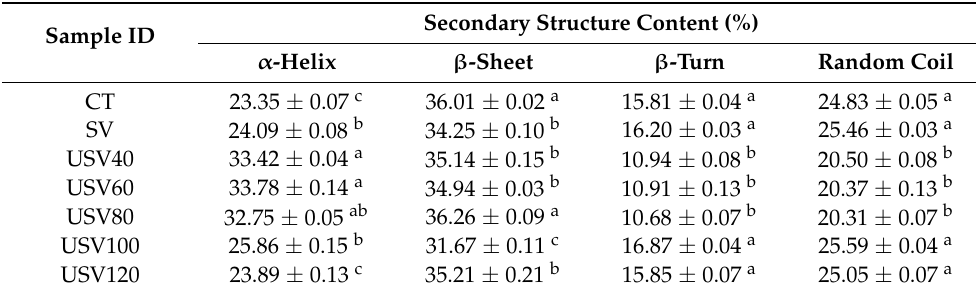
Table 3. Changes in relative protein secondary structure content of spiced beef under different thermal treatments.